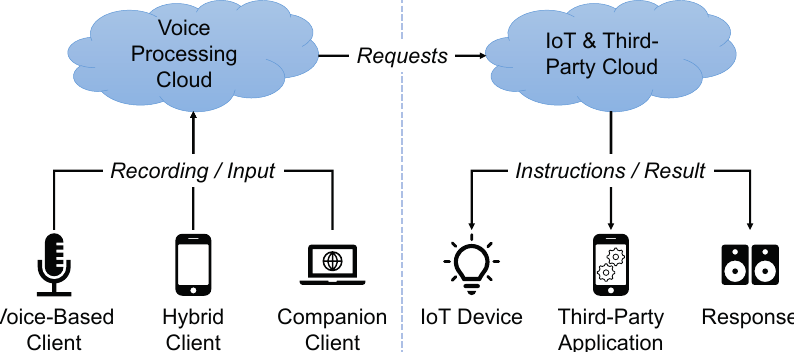
Figure 3. Ecosystem and Architecture of a Voice-Controlled Digital